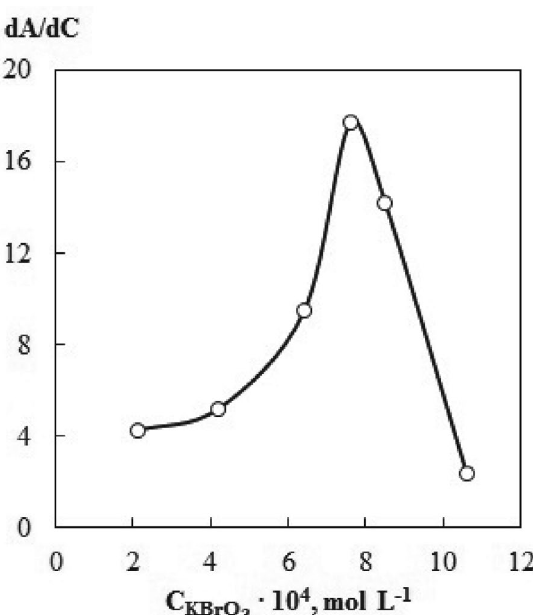
Fig. 4 .The calibration plot for kinetic-spectrophotometric determi- nation of thiocyanate by slope method, C astrafloxine FF = 1 × 10 –5 mol – = 7.6 × 10 –4 mol L –1 ; l = 1 L –1 ; pH 1.5; C BrO 3